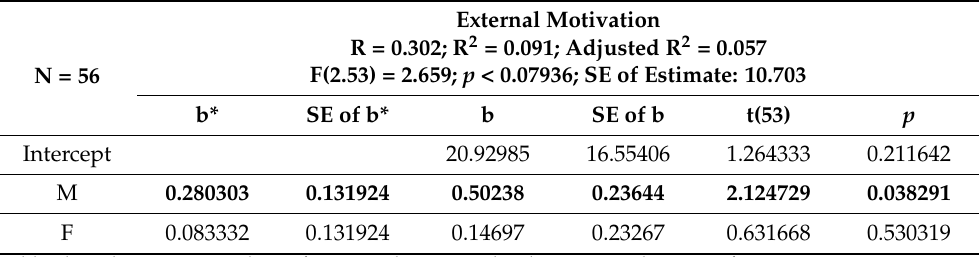
Table 6. Multiple regression explaining variation in extrinsic motivation based on psychological femininity and masculinity in the male study group.